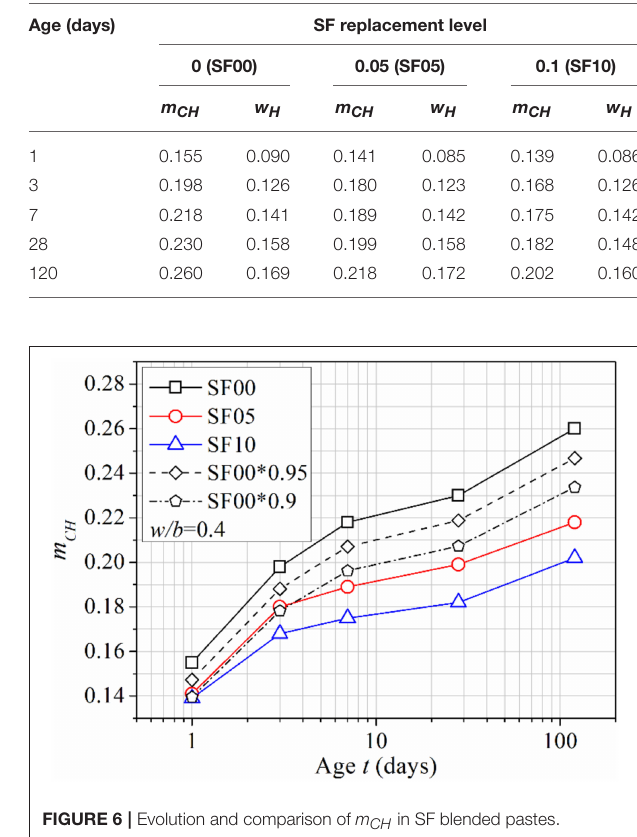
TABLE 4 | Results of TGA for SF blended pastes ( w/b = 0.4).